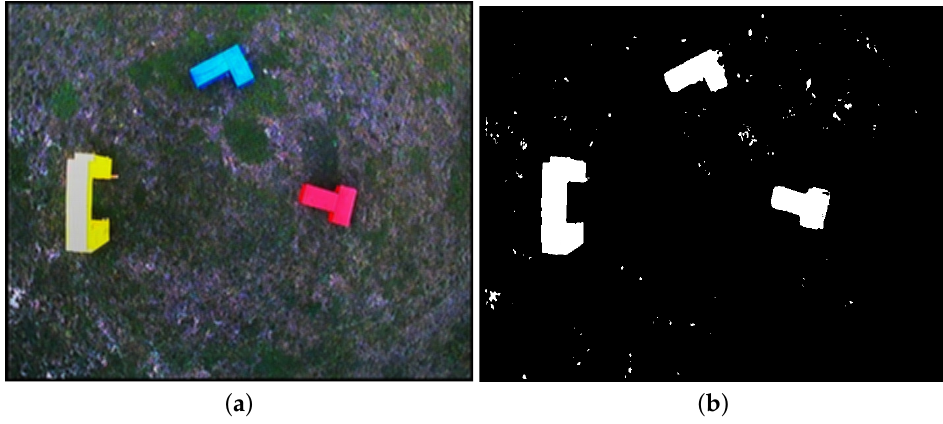
Figure 21. Image of scene taken from altitude of 9 m. Some unwanted artifacts on ground can be seen—see ( b ). Those will be filtered out after vector representation is created. ( a ) preprocessed image; ( b ) exposed areas where predefined colors were identified.